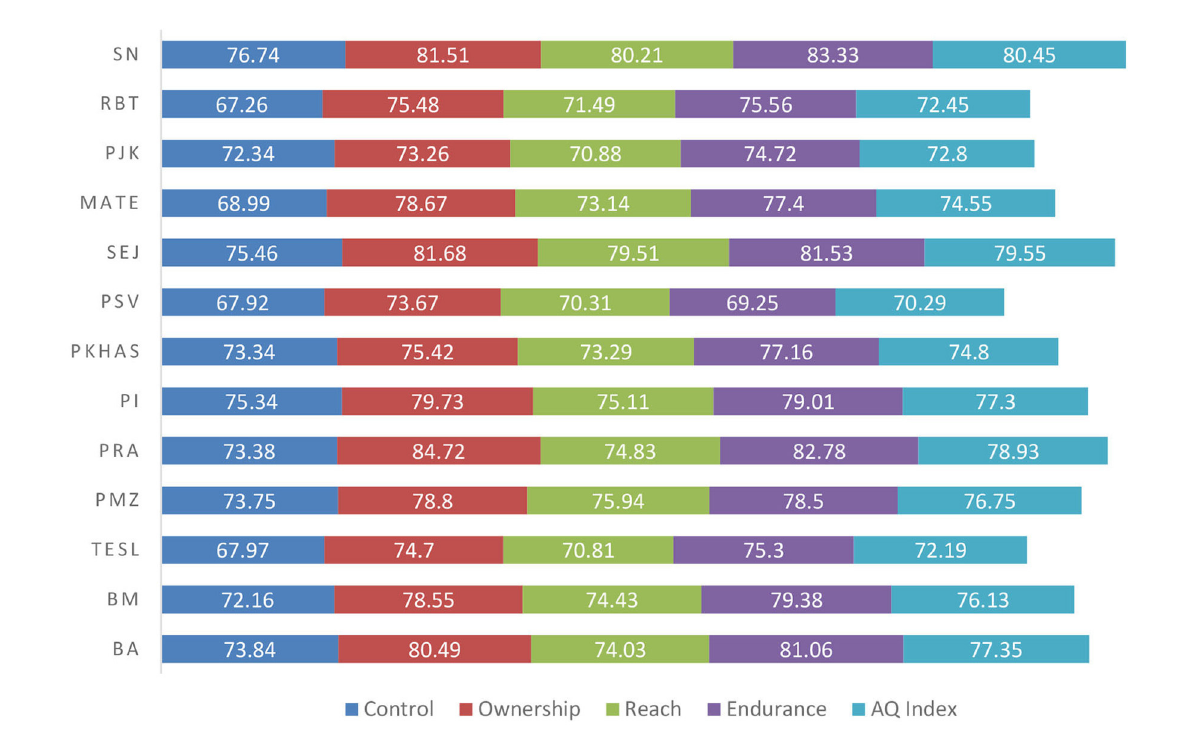
FIGURE5 AQ index comparison of pre-service teachers based on field of study. Arabic (BA), Malay Language (BM), Teaching English as A Second Language (TESL), Music Education (PMZ), Early Childhood Education (PRA), Islamic Education (PI), Special Education (PKHAS), Visual Arts Education (PSV), History (SEJ), Mathematics (MATE), Physical Education (PJK), Design and Technology (RBT), and Science